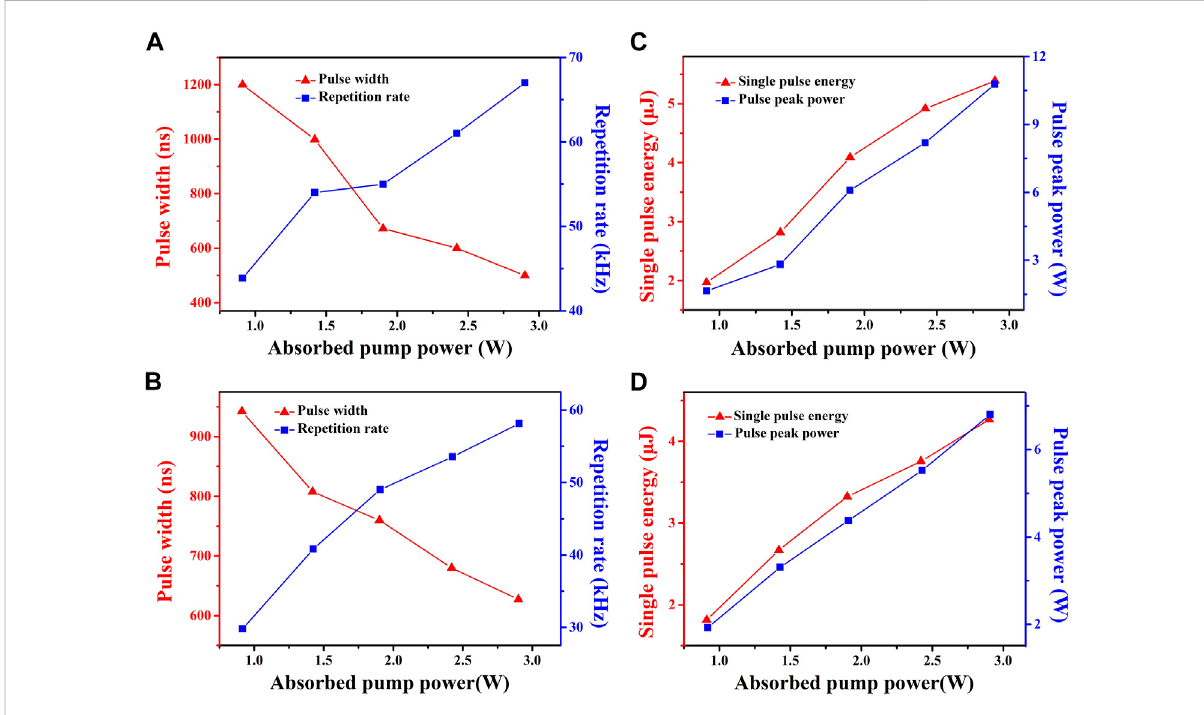
Pulserepetitionrateandpulsedurationversusabsorbedpumppowerat (A) T=2%, (B) T=5%;thedependenceofpulseenergyandpeakpower on the absorbed pump power at (C) T = 2%, (D) T = 5%.